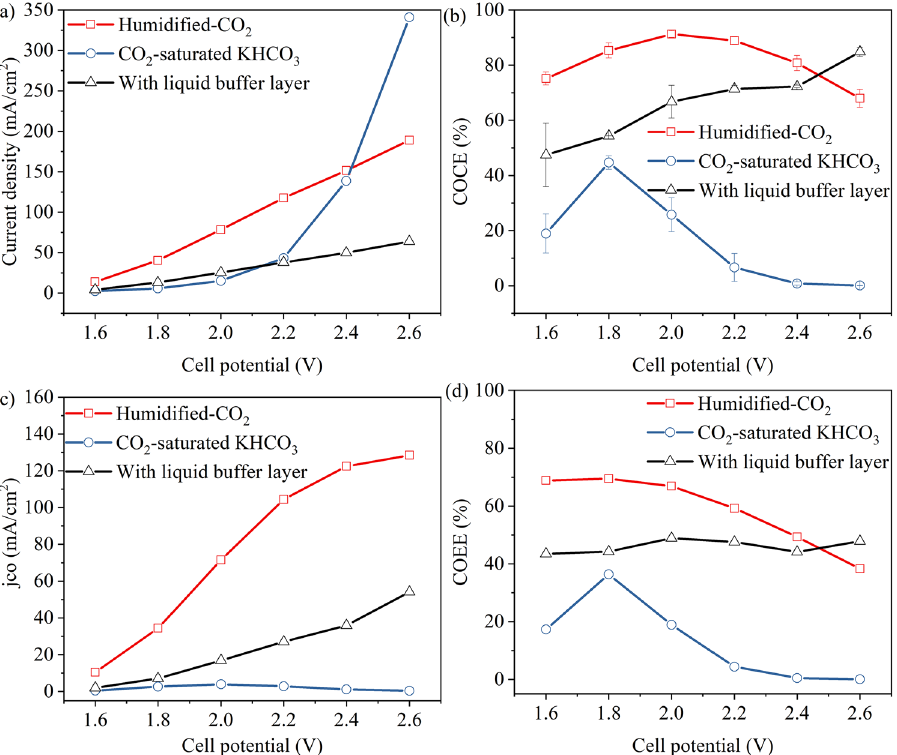
Figure 2. Cell performances acquired with different cathode feeding methods or electrolyser configurations. (a) Average total current density, (b) COCE, (c) average partial current density, and (d) COEE, as a function of the total cell potential.